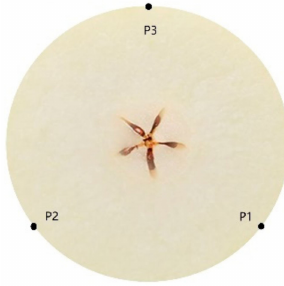
Figure 1. The diagram of the three measuring points (P1, P2, and P3), which were marked around the equator of pear and set as a 120 ◦ angular